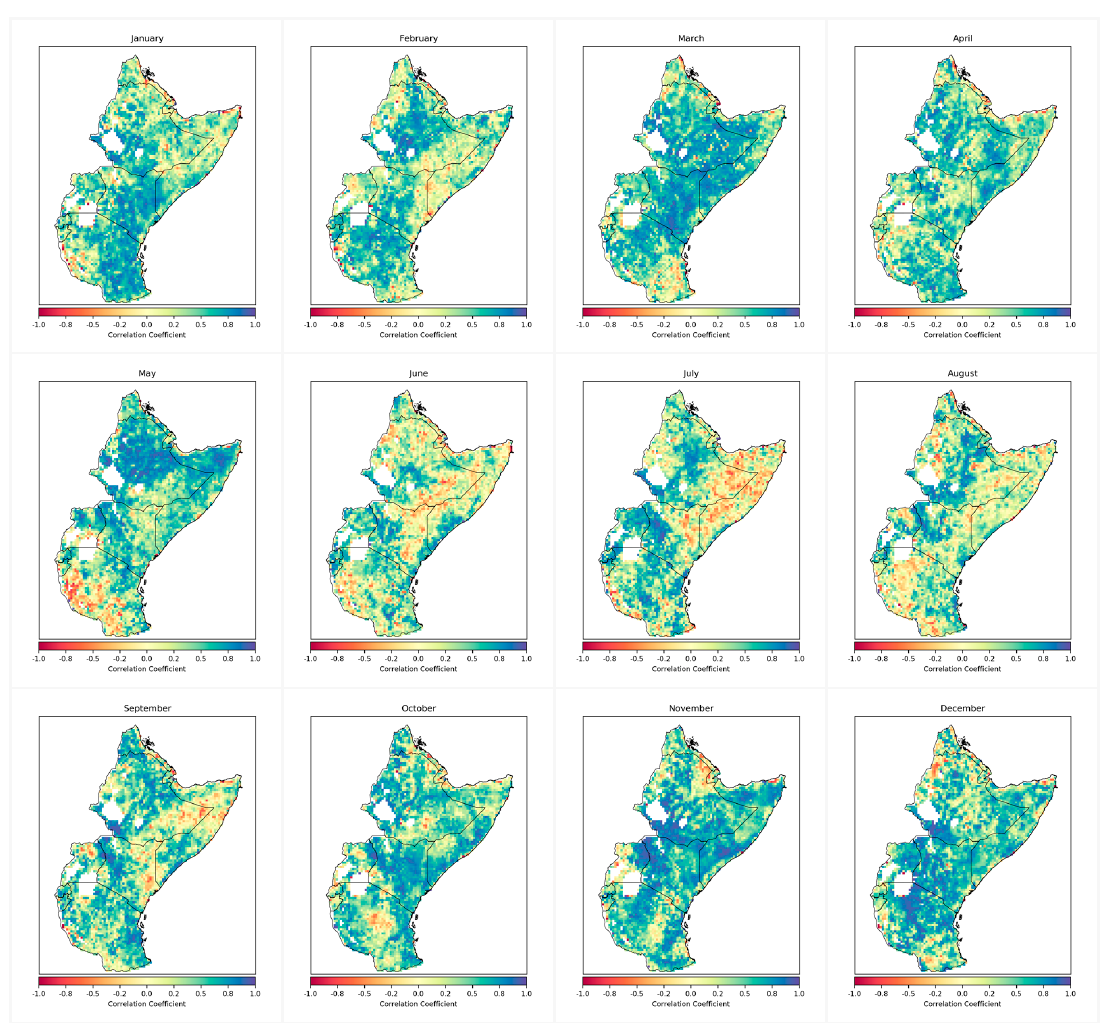
Figure A1. Pearson correlation coefficient for monthly ESA CCI soil moisture estimates and the ESI (2003–2016).